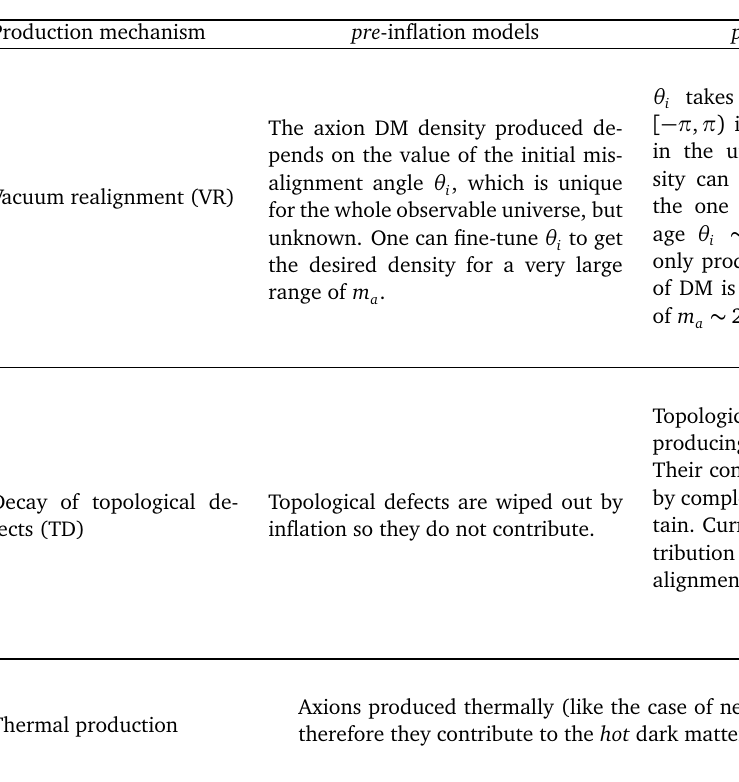
Table 1: Summary of the main relic axion production mechanism, their relevance in pre- or post-inflation models and main model